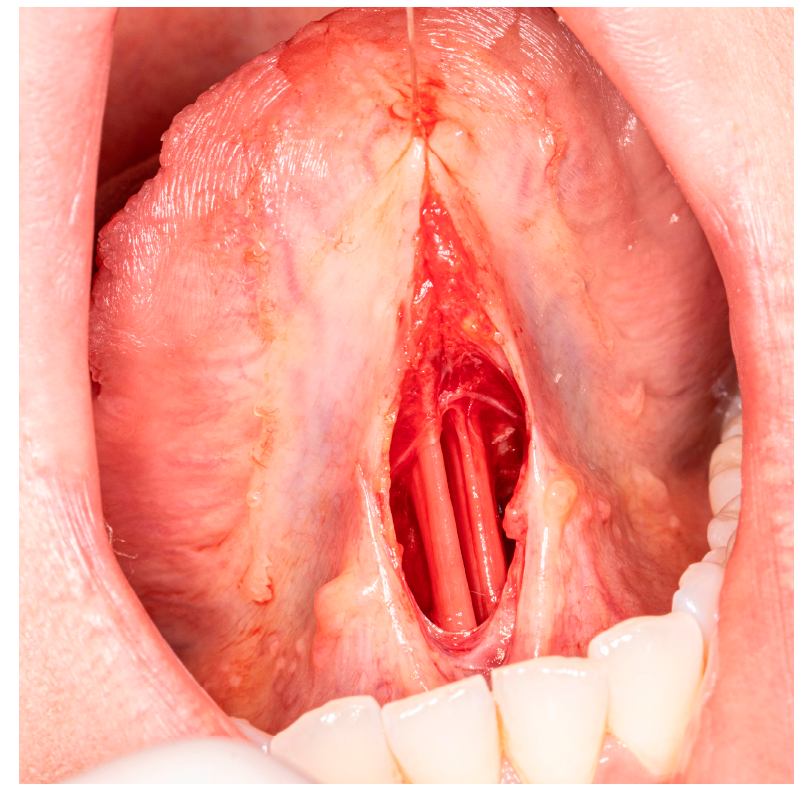
Figure 2. Anterior genioglossus muscle fibers limiting the tongue elevation .